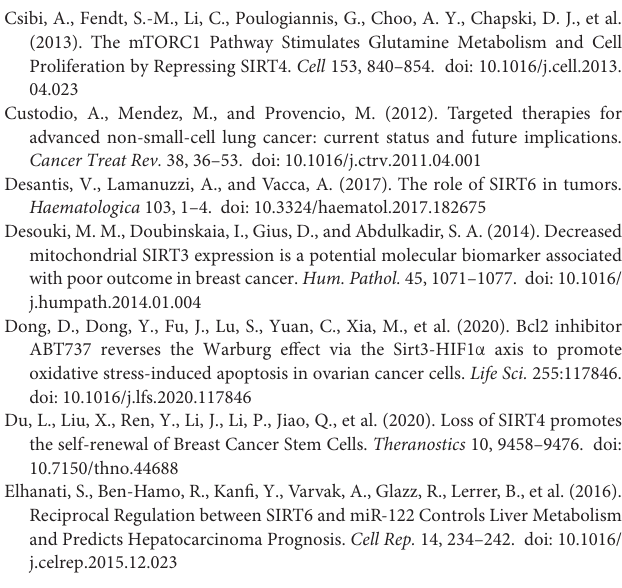
Supplementary Figure 1 | (A) Kaplan–Meier survival plot of SIRT4 in OS (ICGC database). (B) Kaplan–Meier survival plot of SIRT6 in OS (ICGC database). (C) Kaplan–Meier survival plot using the ratio of SIRT4 and SIRT6 in OS. Red indicates higher expression than median; Green indicates lower expression than median (total n = 82). Supplementary Figure 2 | (A) Protein-protein interaction (PPI) network analysis for SIRT4 and SIRT6 with MCL clusters. Red nodes are for SIRT6, and green nodes are for SIRT4. (B,C) The OV cell line methylation association with mRNA RNA-seq expression for SIRT4 and SIRT6. Each dot represents an ovarian cancer cell line. Y axis indicates the correlation of promoter